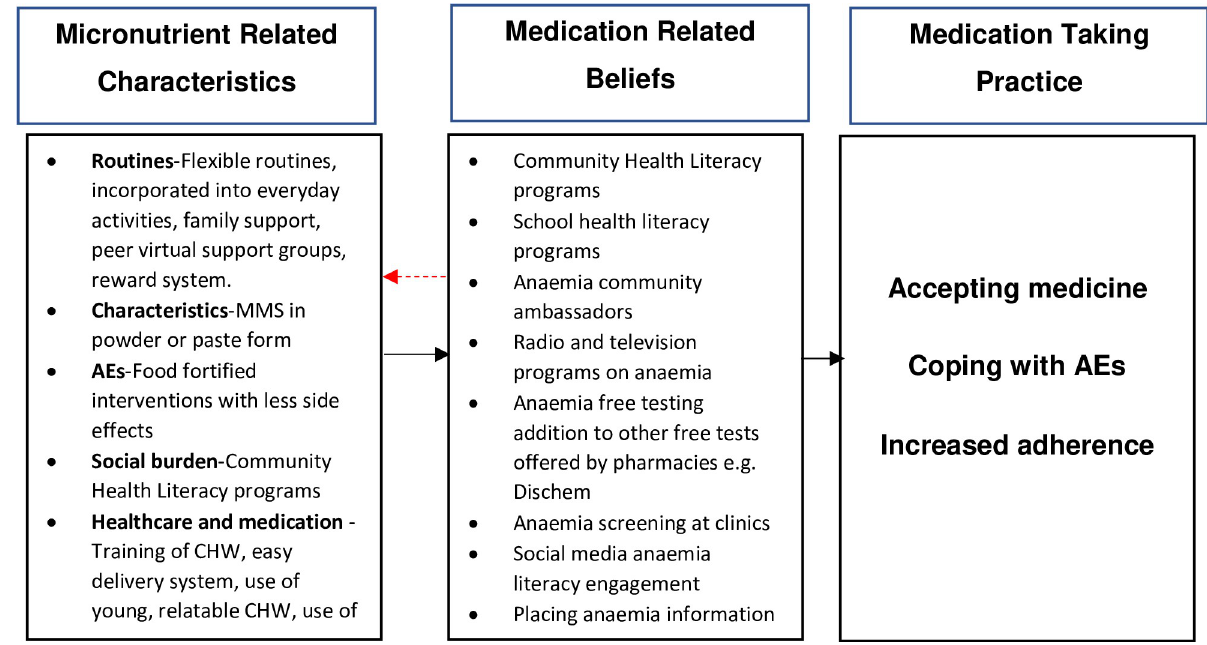
Fig 2. Conceptual framework on patients lived experience with MMS (adapted from Mohammed et al [16]) AEs adverse